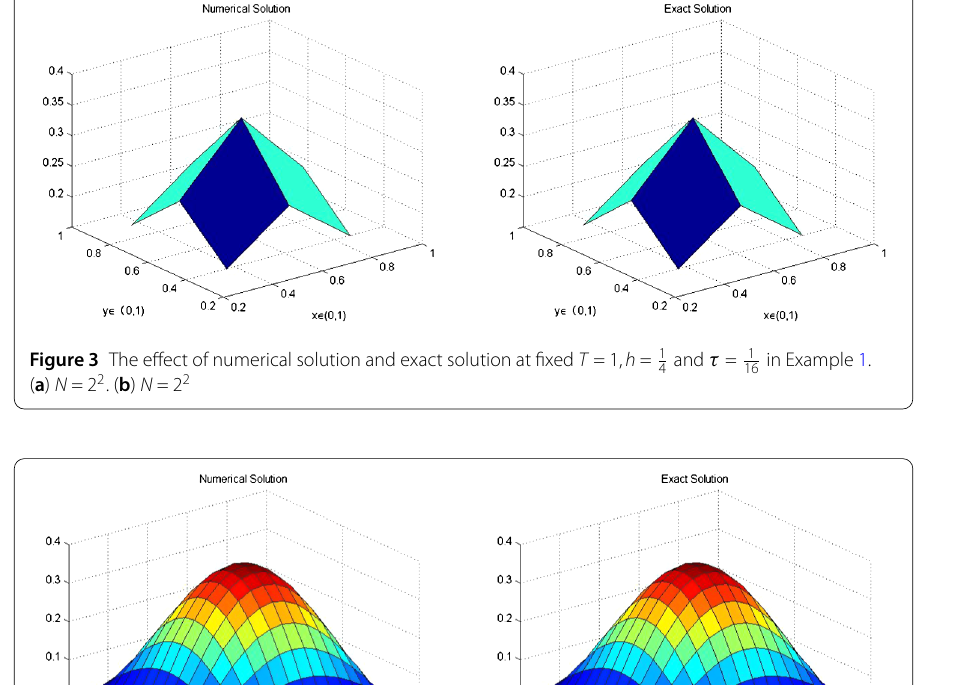
and τ = 1 in Example 1. 8 64